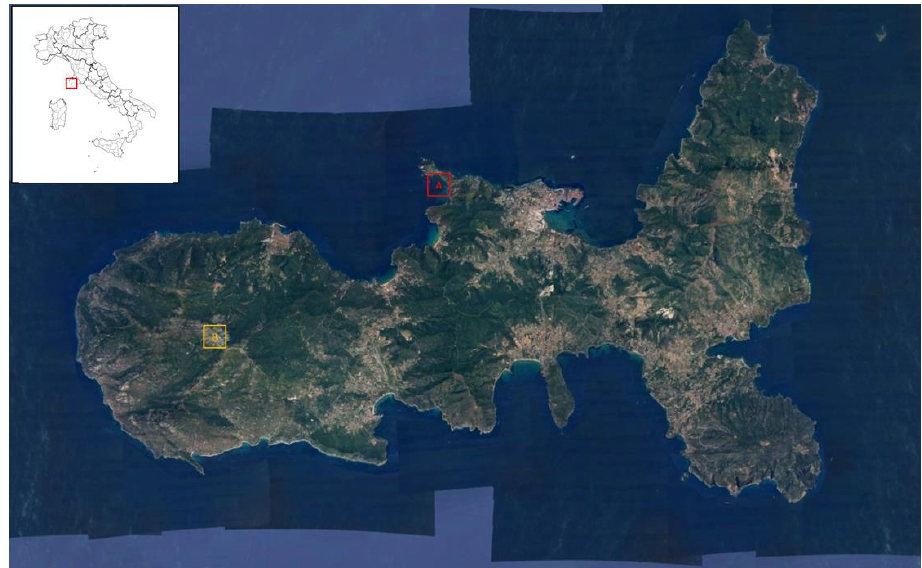
Figure 7. Location of the two study sites on Elba Island: the coastal ( Capo d’Enfola A ) and the mountain (Monte Capanne, B) sites.